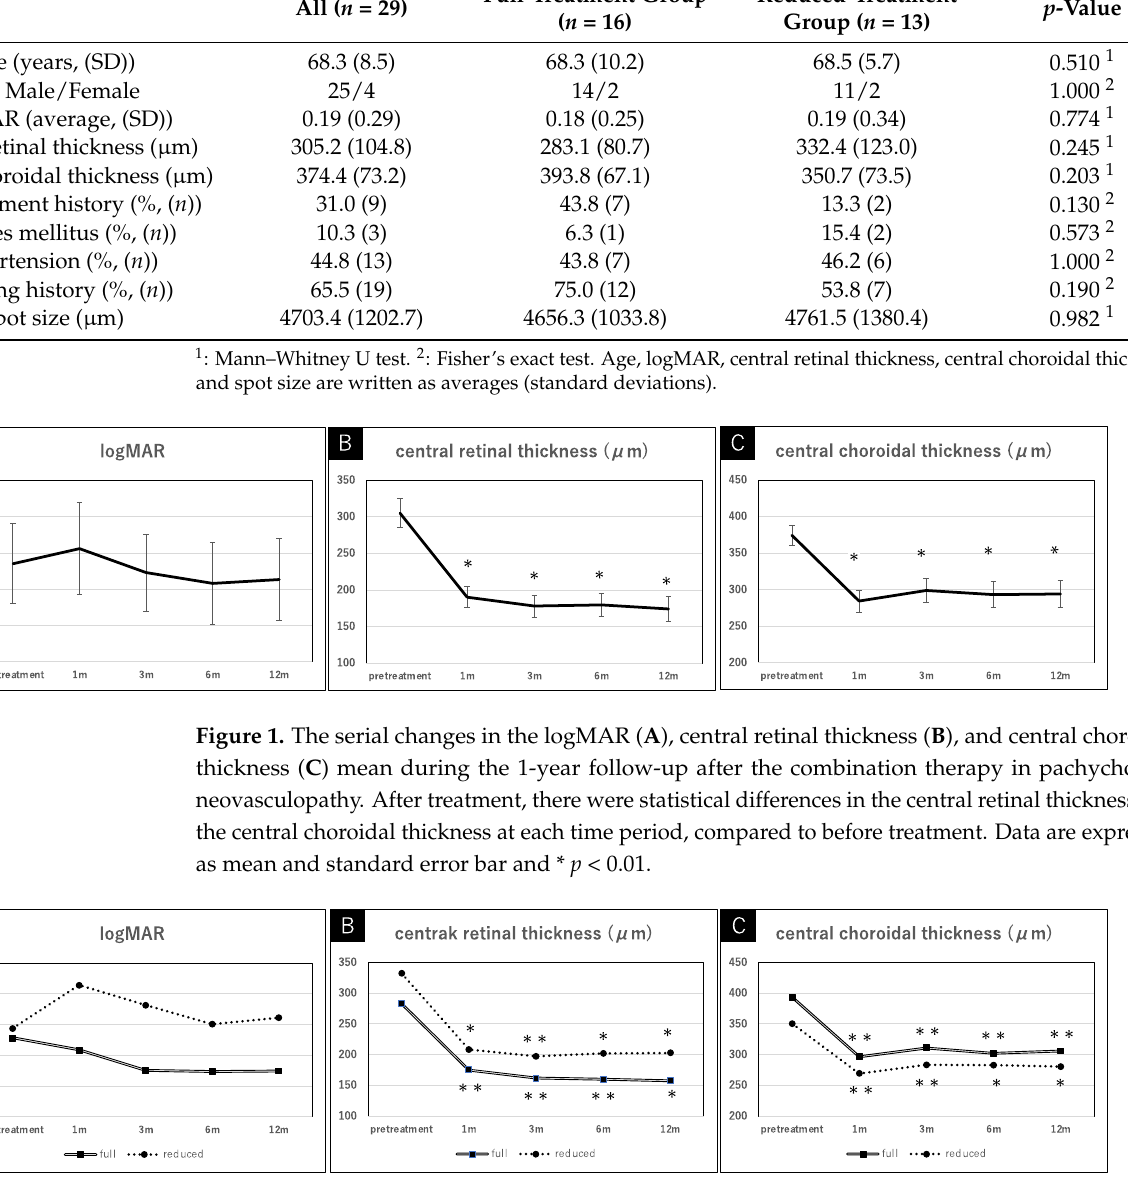
Figure 2. The serial changes in the logMAR ( A ), the central retinal thickness ( B ), and the central choroidal thickness ( C ) mean during the 1-year follow-up after the combination therapy, divided by treatment conditions. Under each treatment condition, there were statistical differences in the central retinal thickness and the central choroidal thickness at each time period, compared to before treatment. Data are expressed as mean and * p < 0.05, ** p < 0.01. After the initial combination therapy, 22 eyes (75.9%) required no additional treat- ments for 1 year, and among them, 6 eyes had past treatment history such as anti-VEGF monotherapy, PDT monotherapy, and photocoagulation. Among the patients with past treatment history, no dry macula or recurrence of fluids were found in 1 person after one month, in 1 person after 6 months, and in 1 person after 9 months within the 12 months of follow-up exams. Divided by treatment condition, 11 eyes (68.8%) in the full-treatment group and 11 eyes (84.6%) in the reduced-treatment group required no additional treat- ment. Divided into the groups with or without past treatment history, 6 out of 9 people (66.7%) and 16 out of 20 people (80.0%) required no additional treatment. Table 2 and Table 3 show the recurrence rate and the total number of additional anti-VEGF treatments during the 1-year follow-up. Table 2. No-recurrence rate and the total number of additional treatments during the 1-year follow- up. All ( n = 29)